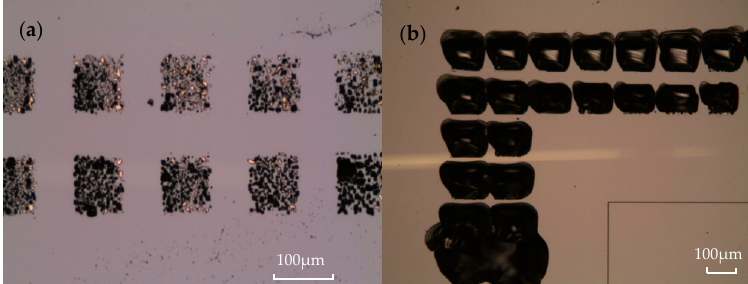
Figure 2. Optical microscope pictures of separated glass surface at different bonding temperature. ( a ) Bonding at 380 °C, some Si particles could be seen; ( b ) bonding at 400 °C, big pieces of silicon peeled off from bulk Si.